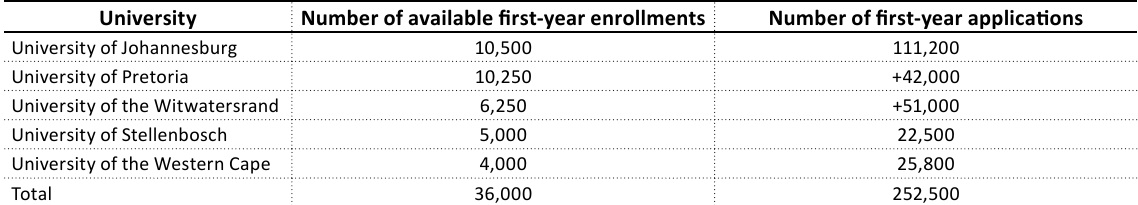
Table 1. Number of available first-year enrollments and number of applications received at five selected HE institutions in